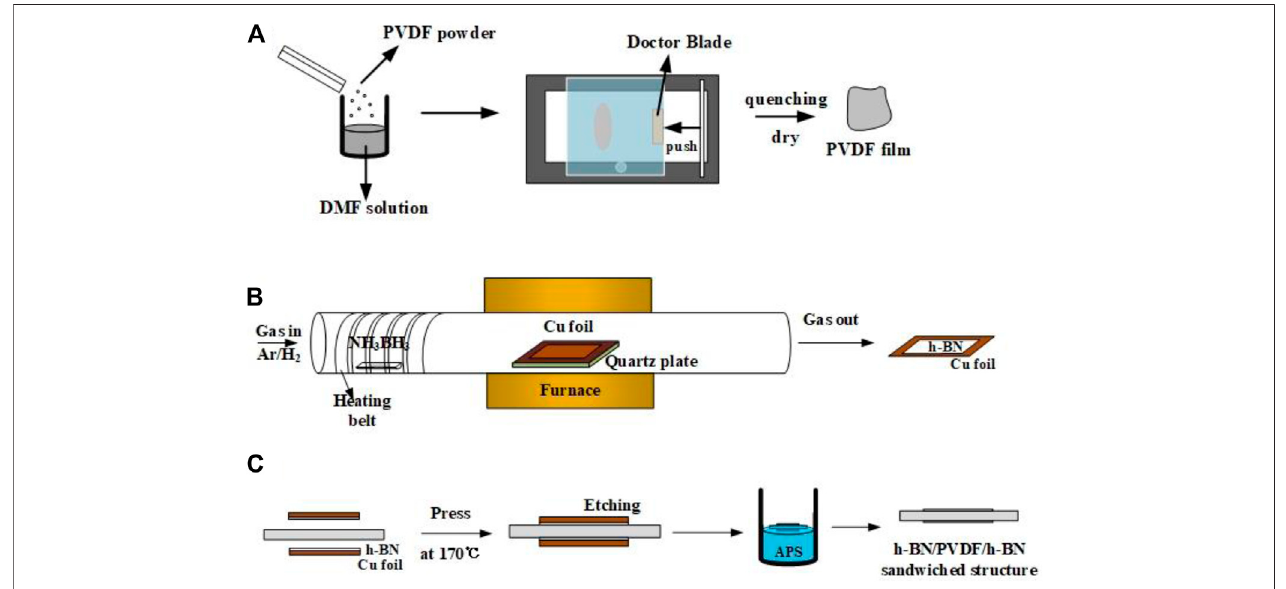
FIGURE 1 | Preparation process of pristine PVDF fi lms (A) , h-BN/Cu fi lms (B) and h-BN/PVDF/h-BN sandwich-structured fi lms (C) .